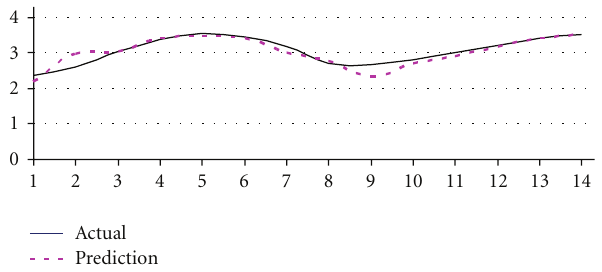
Figure 5: ANN model prediction of lynx data (test sample).